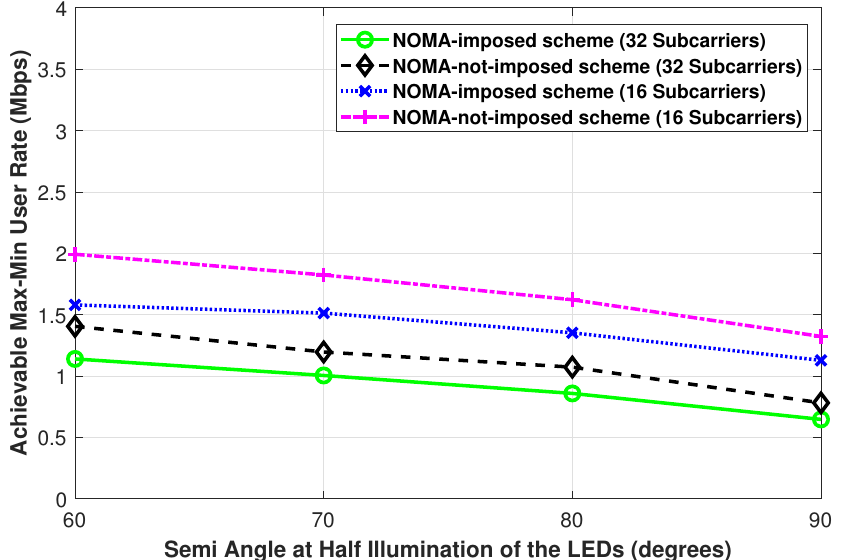
Figure 7. The achievable max-min user rate of the NOMA-imposed scheme and the NOMA- not-imposed scheme obtained while changing the semi-angle at half illumination of the LEDs.